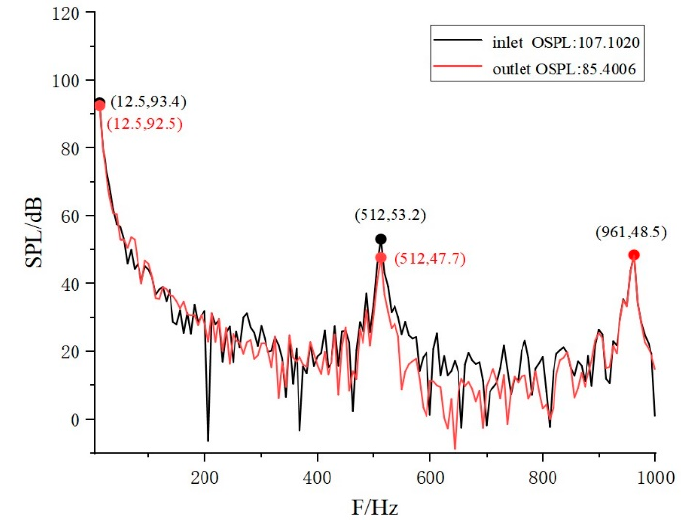
Figure 27. Spectrum diagram with 3 times flow area.